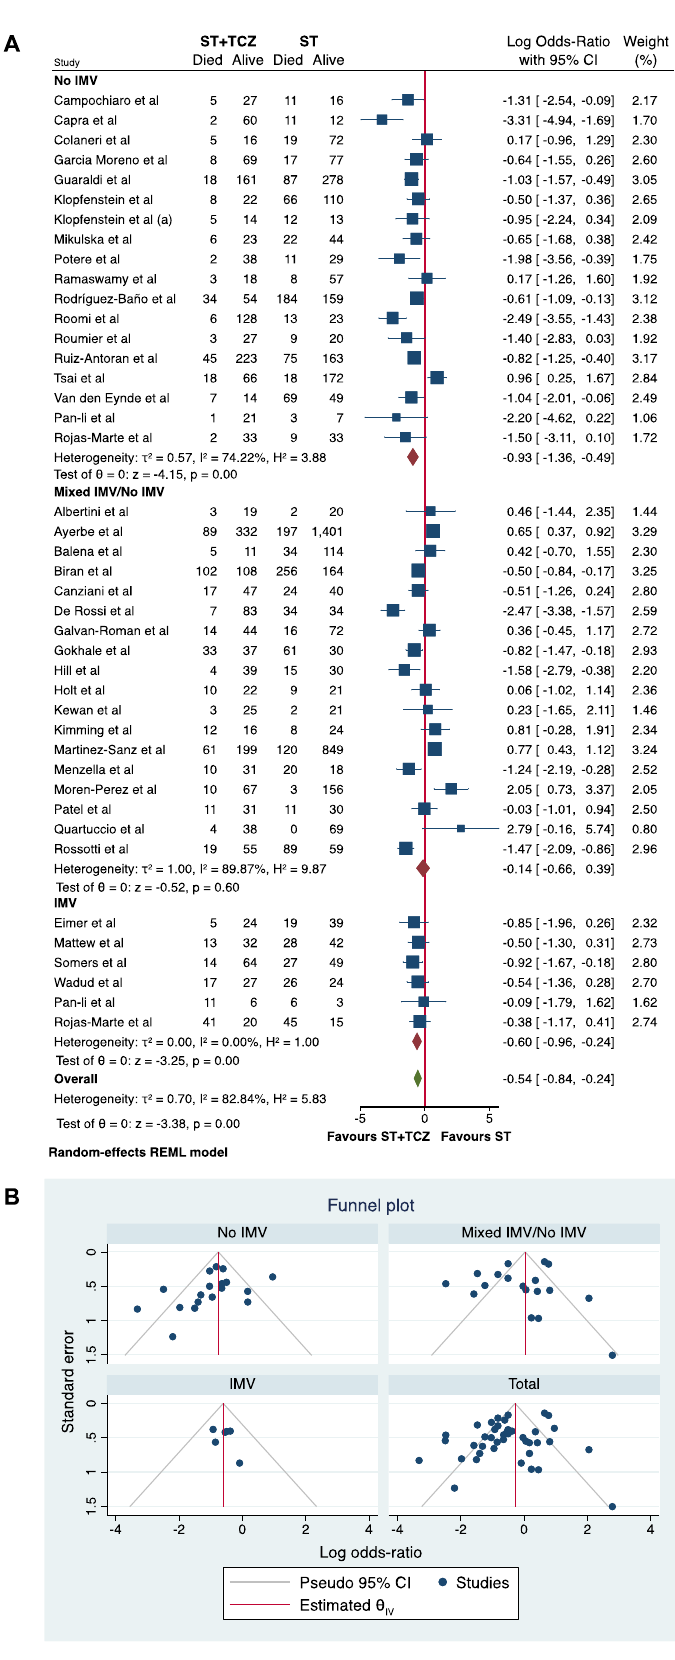
Figure 6. ( A ) Forest plot and ( B ) funnel plot of the subgroup analysis on the observational studies stratified by IMV